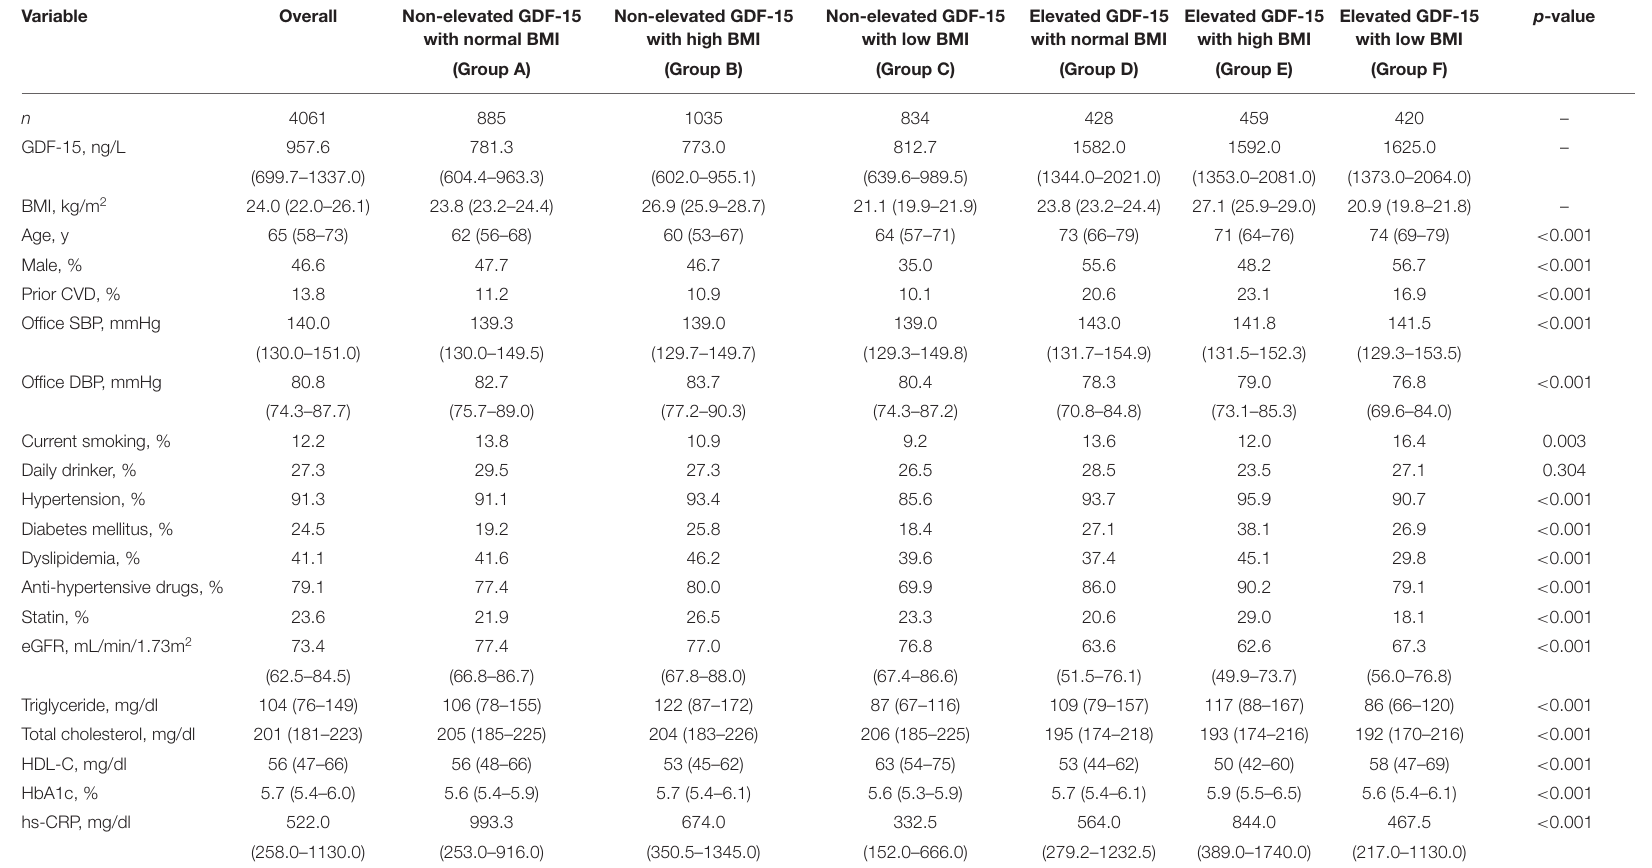
TABLE 1 | Baseline